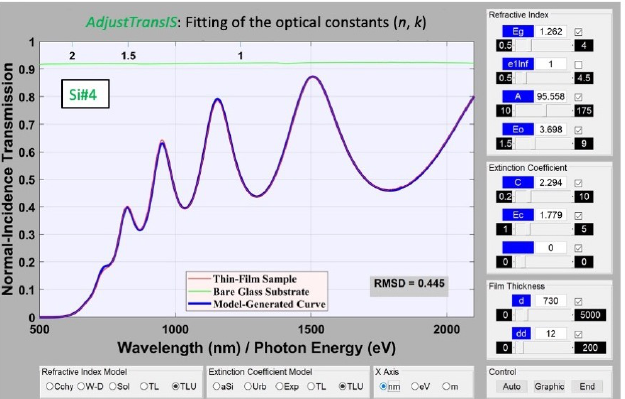
Figure A1. GUI screenshots for the determination of the optical constants of Si#3 and Si#4 thin- film samples, corresponding to the created Matlab-coded program, ‘AdjustTransIS’. Appropriate checkboxes and radio buttons are employed for the quick and accurate transmission-data